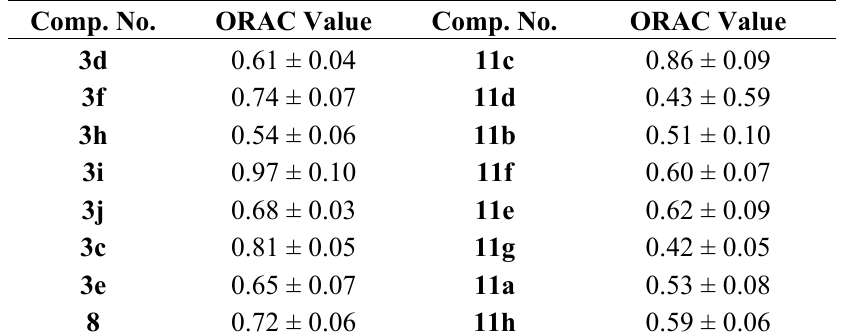
Table 3. ORAC values for antioxidant activity of compounds 3 , 8 , and 11 . Comp. No. ORAC Value Comp.